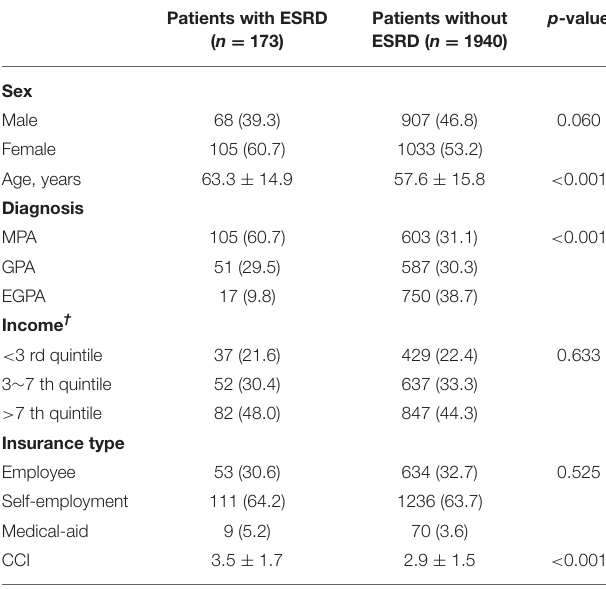
TABLE 3 | Baseline characteristics of ANCA-associated vasculitis patients TABLE 4 | Basal characteristics of ANCA-associated vasculitis patients with and suffering mortality and without. without ESRD. Patients with ESRD p -value Patients with Patients without ( n = mortality ( n = 567) mortality ( n = 1546)